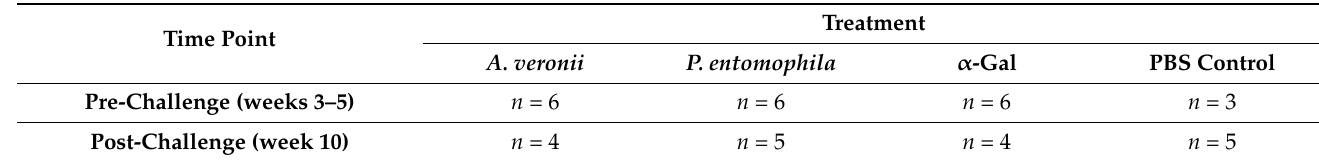
Table 5. Description of samples per treatment group and time